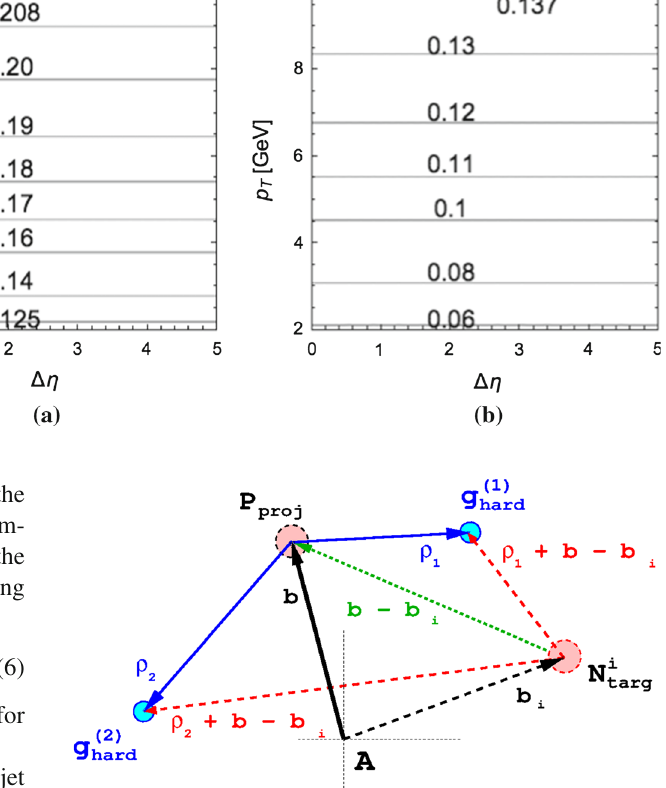
( 1 , 2 ) , pointed hard